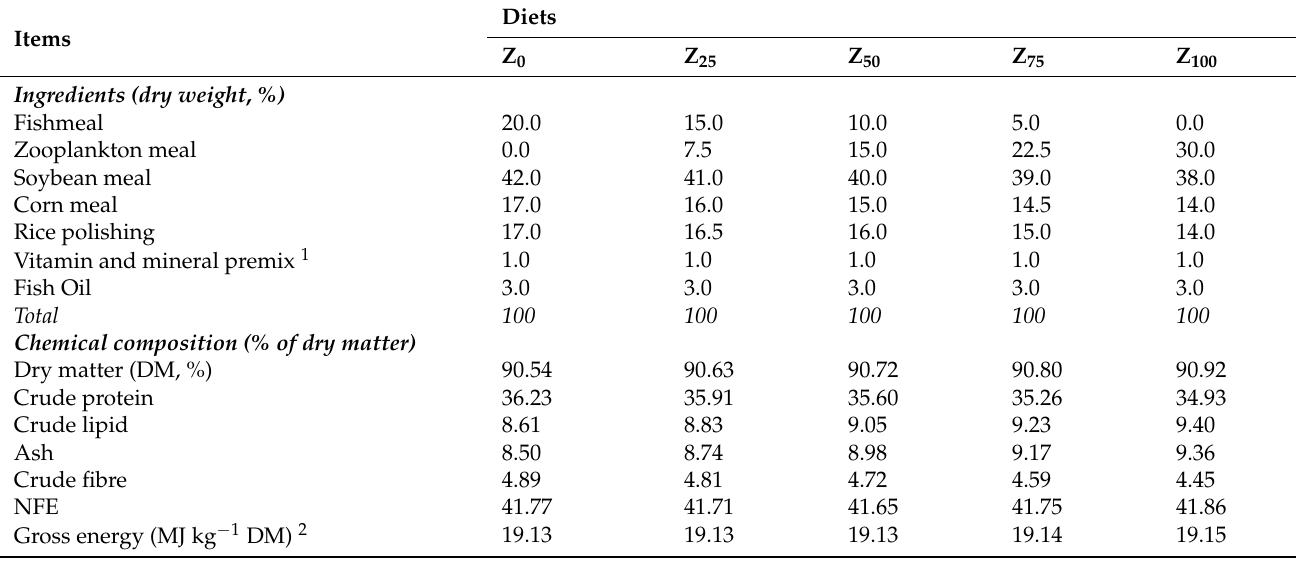
Table 2. Formulation and approximate composition of experimental diets (dry weight,